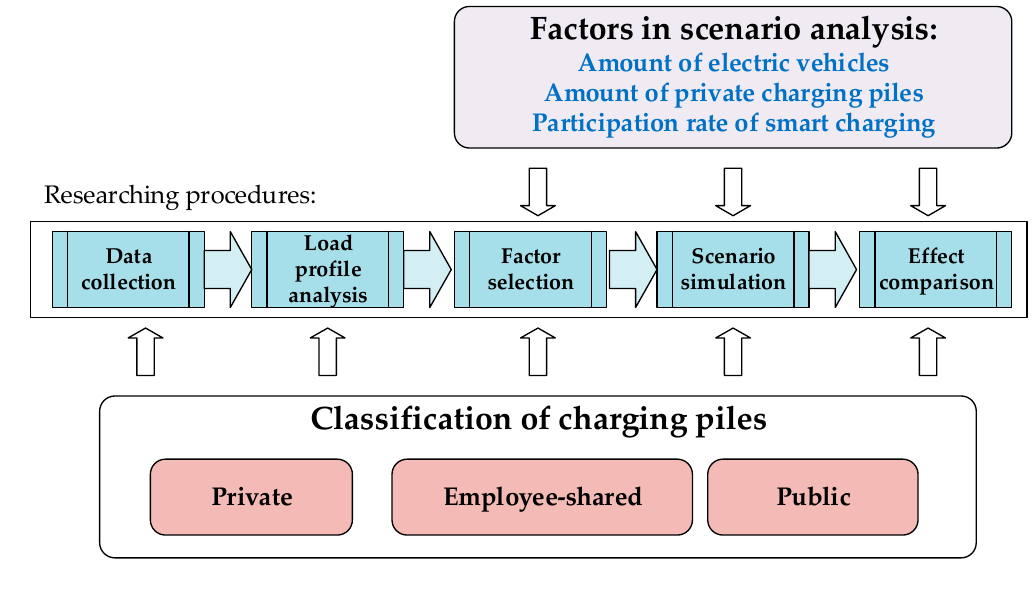
Figure 1. Research scheme.